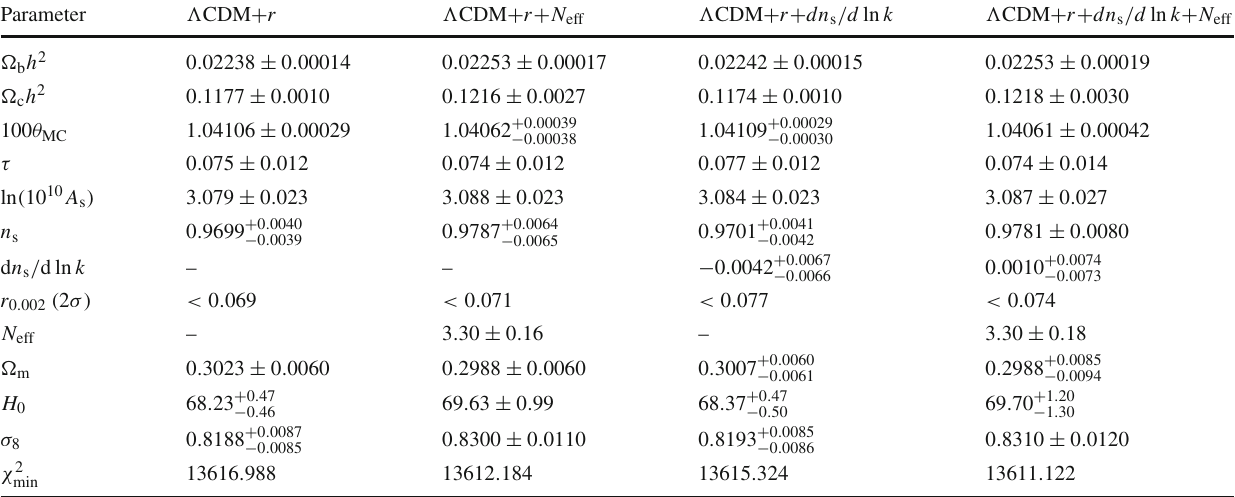
Table 1 The fitting results of the cosmological parameters in the (cid:2) CDM + r , (cid:2) CDM + r + N eff , (cid:2) CDM + r + dn s / d ln k , and (cid:2) CDM + r + dn / d ln k + N s eff models using the Planck